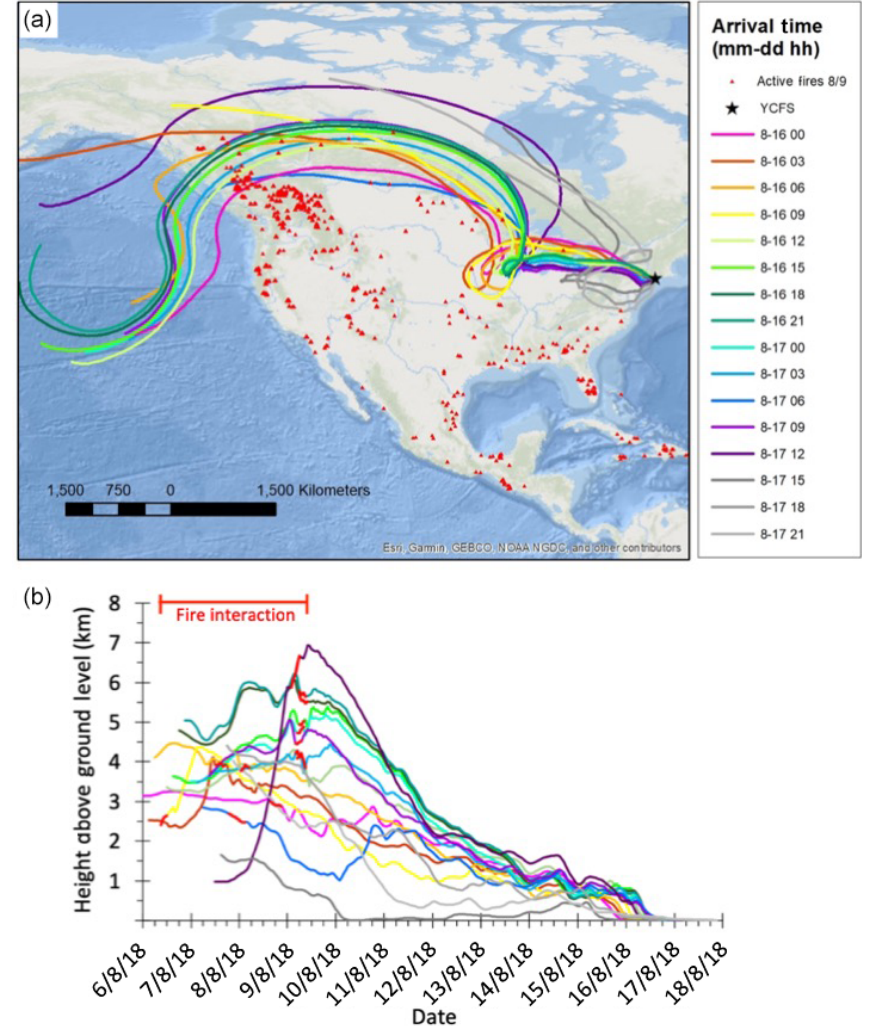
Figure 5. NOAA HYSPLIT back-trajectory model results for air parcels arriving on 16 and 17 August 2018 to surface-level YCFS site. Each line represents the backward trajectory for an air parcel arriving every 3h throughout the course of the day. The location of fires on 9 August (when most trajectories intersect the wildfire zone on the western coast of North America) is depicted with red triangles (from NOAA HMS fire maps). The top map (a) shows the full 10d trajectory, and the bottom figure (b) shows the vertical height of each air parcel along its trajectory as well as the times where it may have intercepted wildfire smoke plumes (highlighted in red on each individual trace and bracketed above). The last three trajectories on 17 August have no major fire interaction and have thus been colored